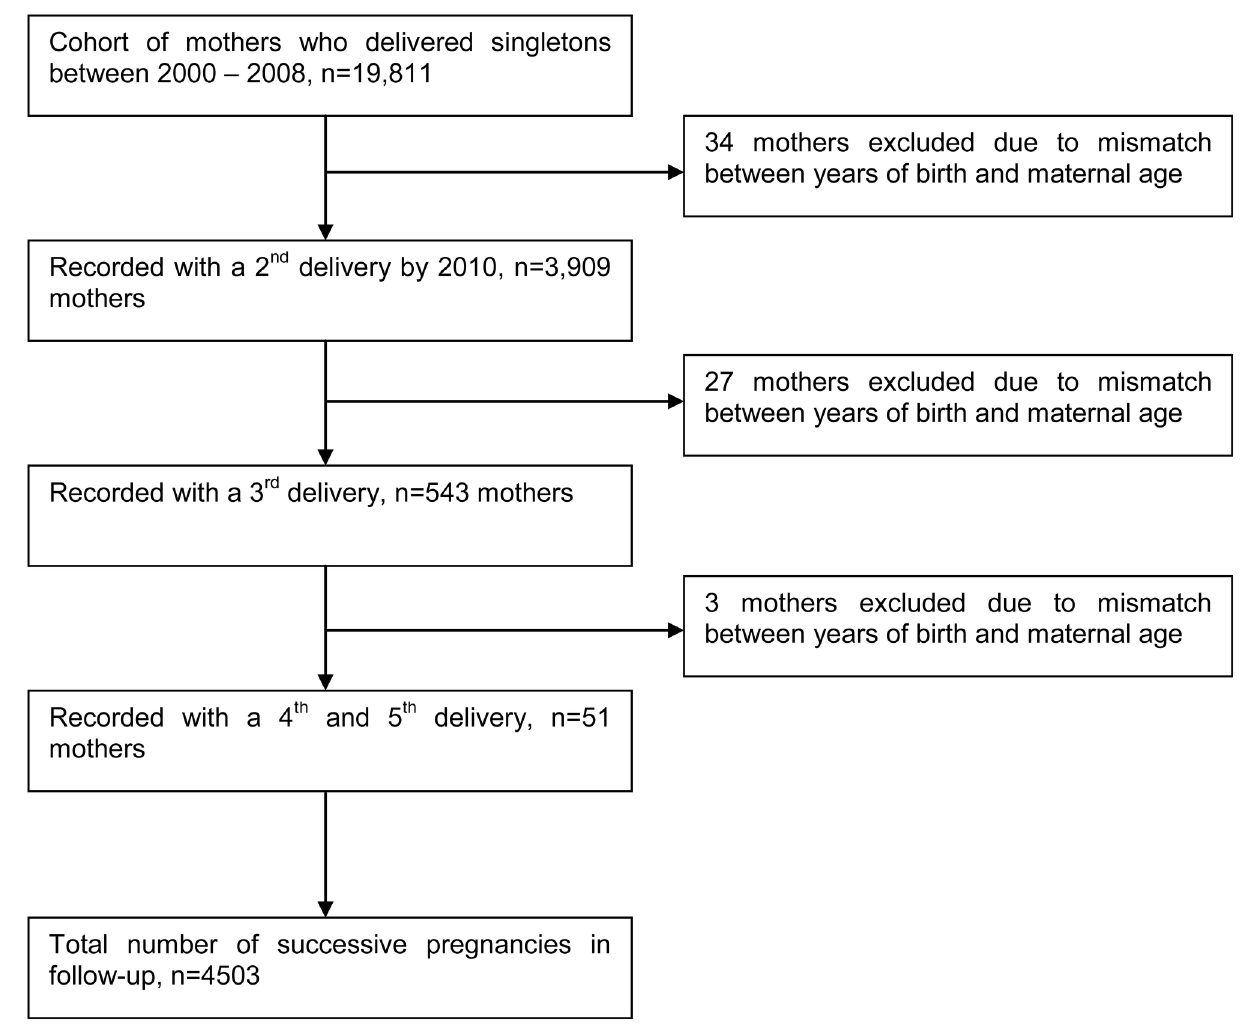
Figure 1. Schematic presentation of the cohort follow-up. Data from the Kilimanjaro Christian Medical Centre (KCMC) birth